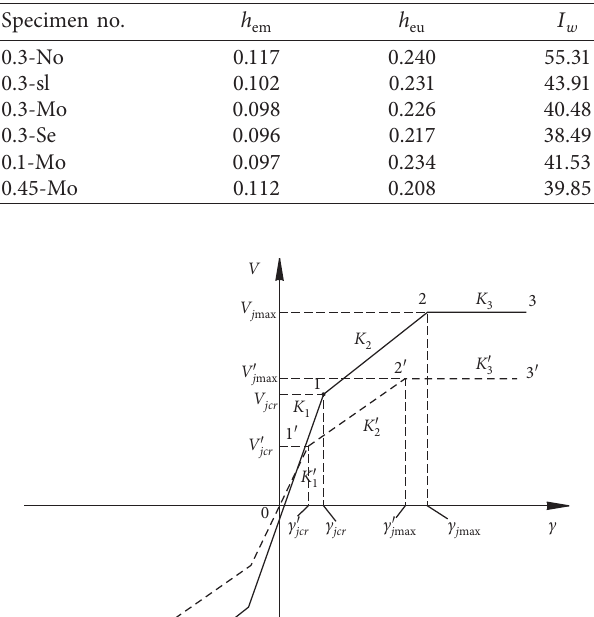
Figure 9: Schematic diagram for calculating equivalent viscous damping coefficient. Table 6: Energy dissipation indices of specimens.